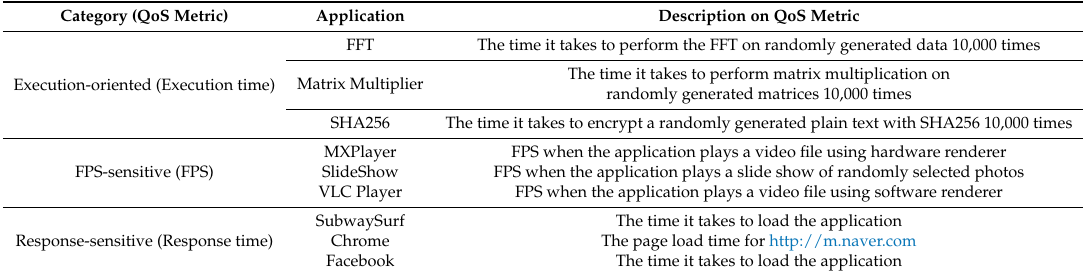
Table 2. Categorization of the 9 applications used in our